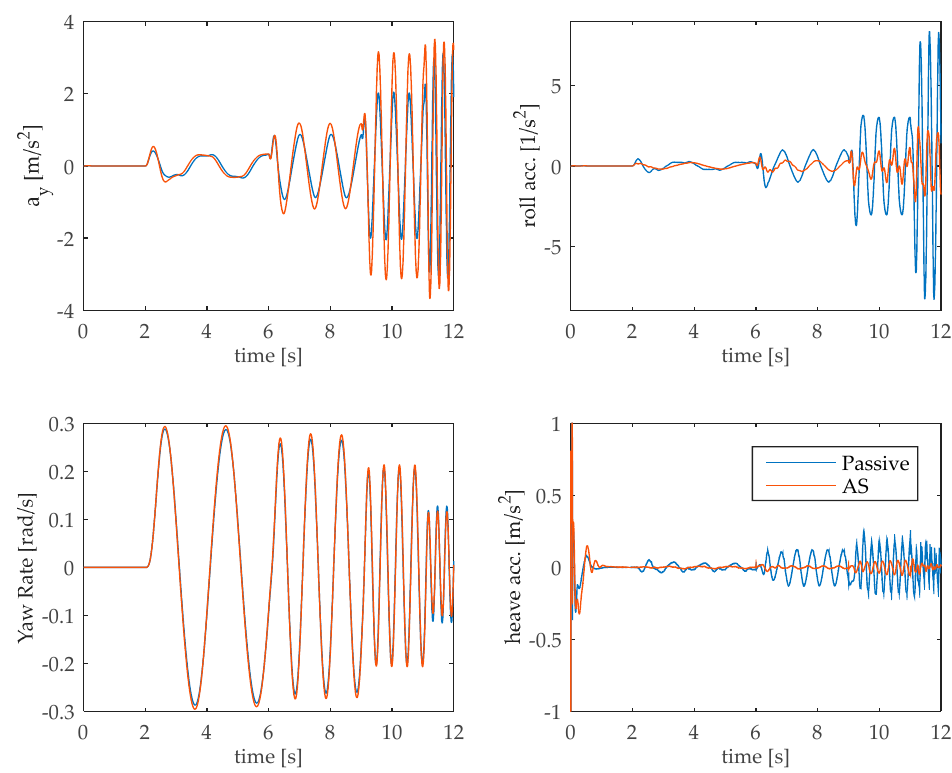
Figure 11. Simulation results for the sweep test. The graphs on the left side show the vehicle lateral acceleration and yaw rate, respectively. The graphs on the right side show the roll and heave acceleration, respectively.